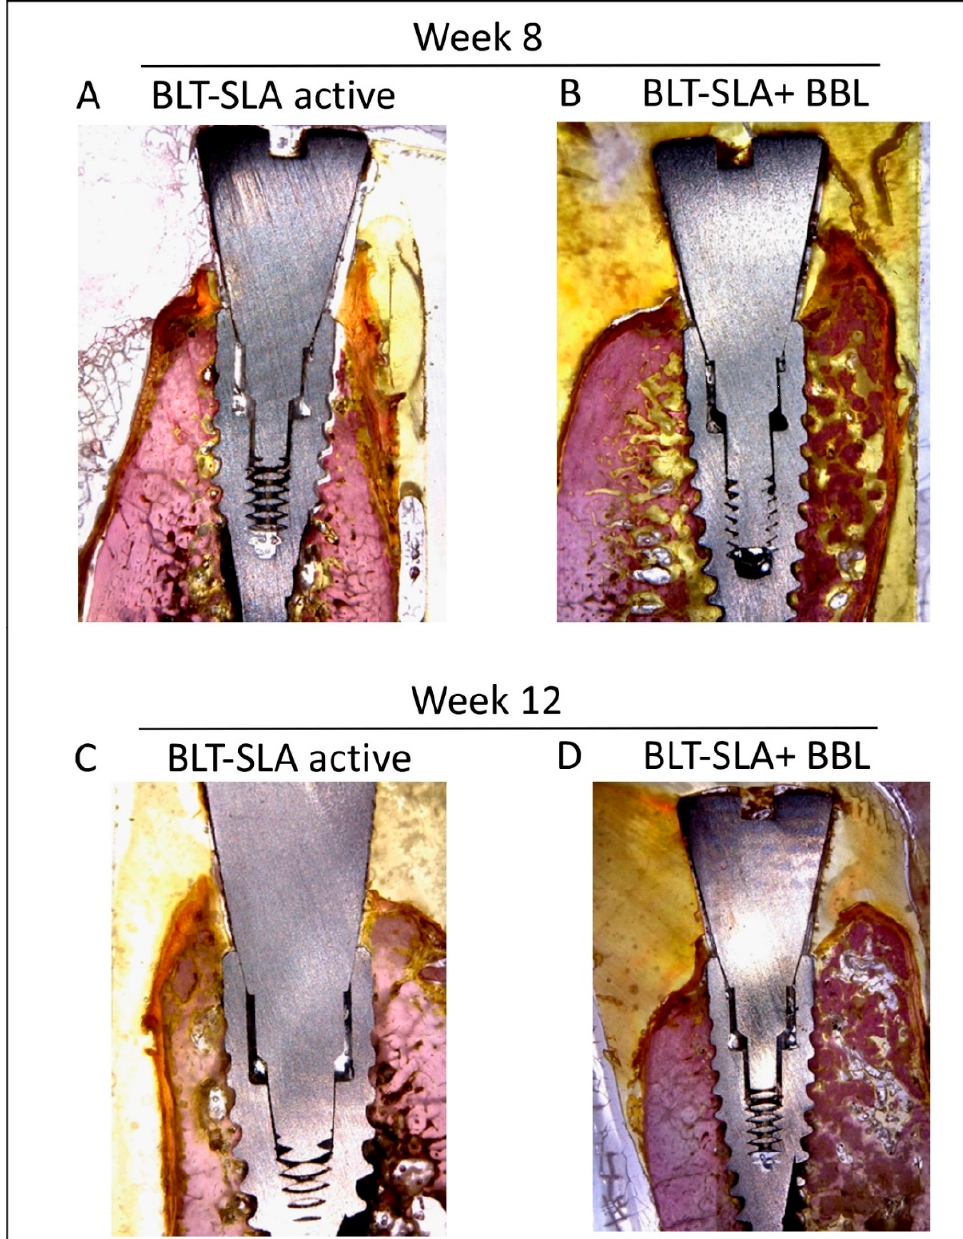
Figure 2. Representative image Illustrating the implants. ( A ) Week 8, BLT-SLA active implant showed moderate bone remodeling with slight resorption at the buccal wall. ( B ) Week 8, BLT-SLA + BBL liquid represented enriched bone remodeling and increased bone crest above the neck of the implant at both the buccal and lingual wall crest. ( C ) Week 12, BLT-SLA active showed stable generation of soft and hard tissues flanking the buccal and lingual crests. ( D ) Week 12, BLT-SLA + BBL liquid showed an enrichment of bone at the buccal wall, whereas soft tissue enrichment was observed at the lingual wall. All images were taken at magnification 12.5 ×